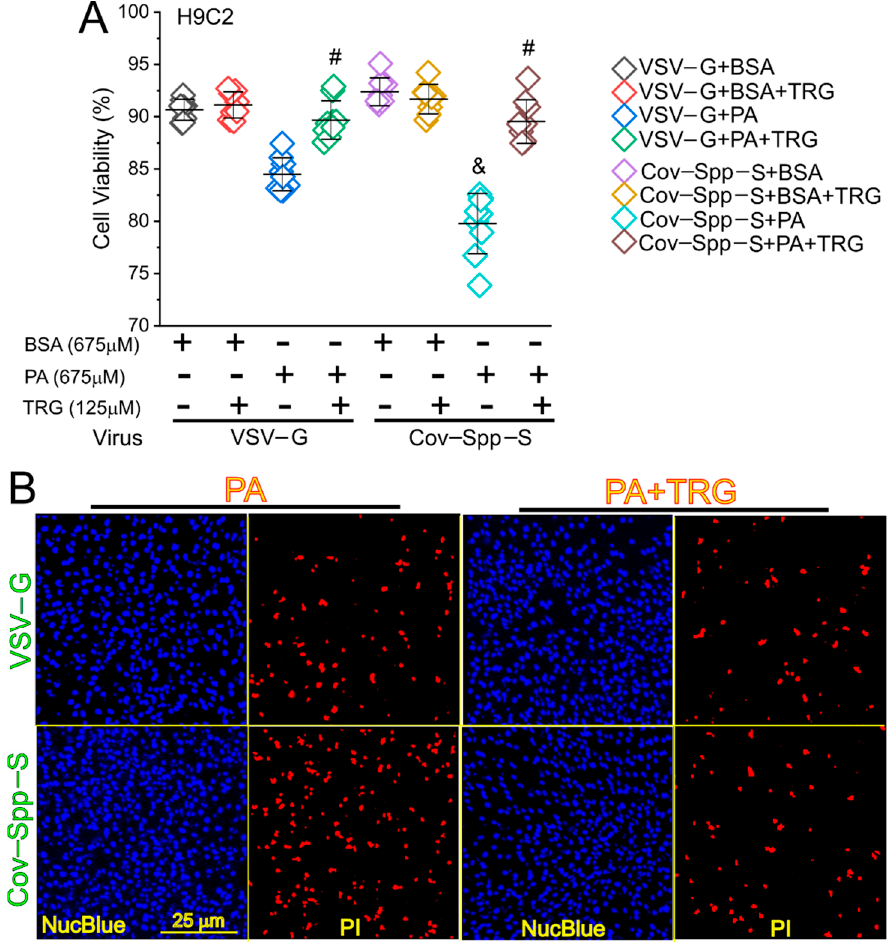
Figure 6. TRG attenuated the Spike protein exaggerated PA-induced necrosis in H9C2 cells. ( A ) Quantitative data showing the cell viability of H9C2 cells after being infected by VSV-G or Cov-Spp-S lentivirus followed by PA treatment with or without TRG. BSA was used as a treatment control. &, indicates p < 0.05 in the Cov-Spp-S-infected cells as compared with the VSV-G-infected cells upon PA treatment. #, indicates p < 0.05 in the cells treated with PA plus TRG as compared with the cells treated with PA only. ( B ) Fluorescent images showing the cell viability in the VSV-G- or Cov-Spp-S-infected H9C2 cells after PA treatment with or without TRG in DMEM containing 5% FBS. The cells were co-stained by Propidium Iodide (PI) and Hoechst 33342 NucBlue Live Cell Stain dye to show the dead and live cells.